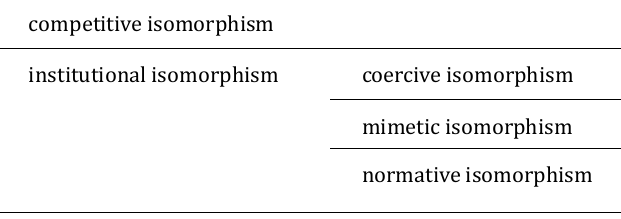
Table 1. Mechanism of isomorphic organizational